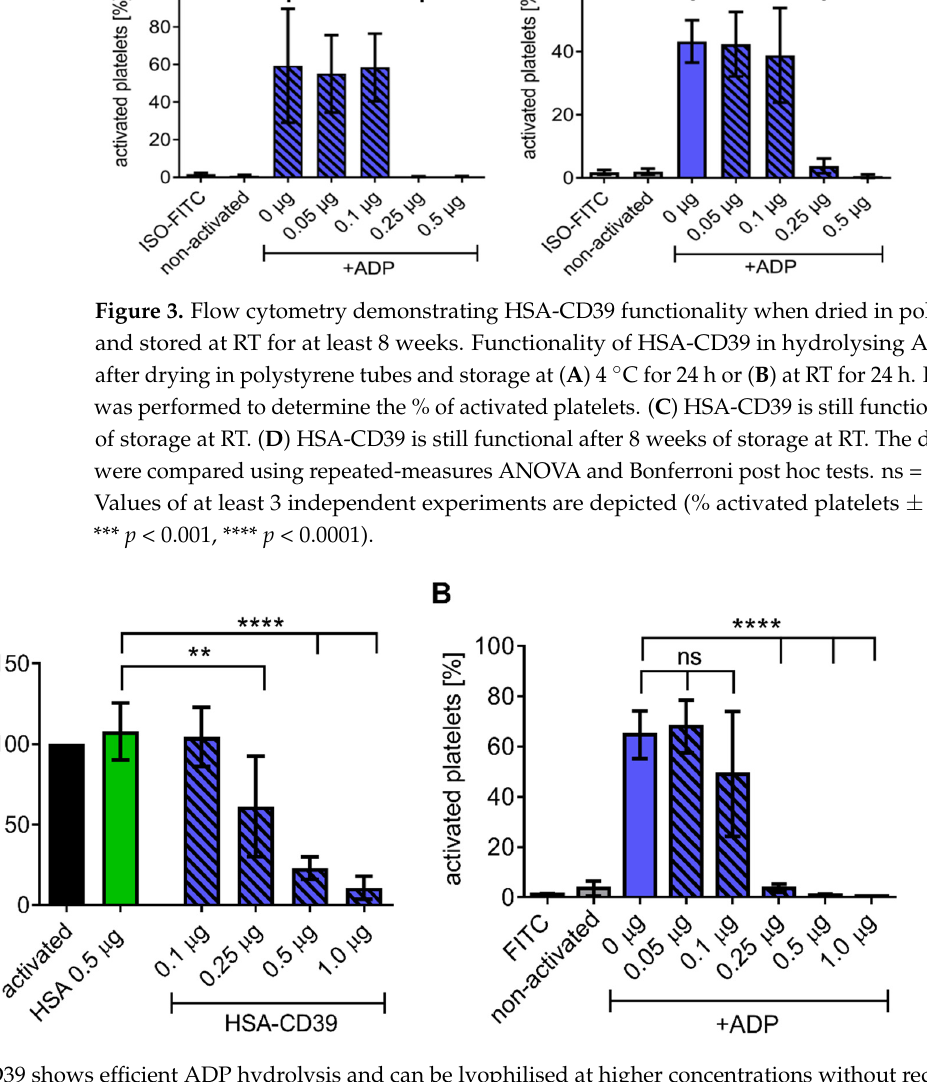
Figure 4. HSA–CD39 shows efficient ADP hydrolysis and can be lyophilised at higher concentrations without reduction in functionality. ( A ) Bioluminescence assay showing a reduced ADP concentration (%) for increased HSA–CD39 concentrations compared to the HSA control (** p < 0.01; **** p < 0.0001 compared to 0.5 µg HSA control, n = 4). Different groups were compared using repeated-measures ANOVA and Sidak’s test. ( B ) Functionality of lyophilised HSA–CD39 shows that high amounts of the fusion protein (>1.0 µg) are still active after lyophilisation ( n = 4, **** p < 0.0001 compared to PBS control). Values of at least 3 independent experiments are depicted.